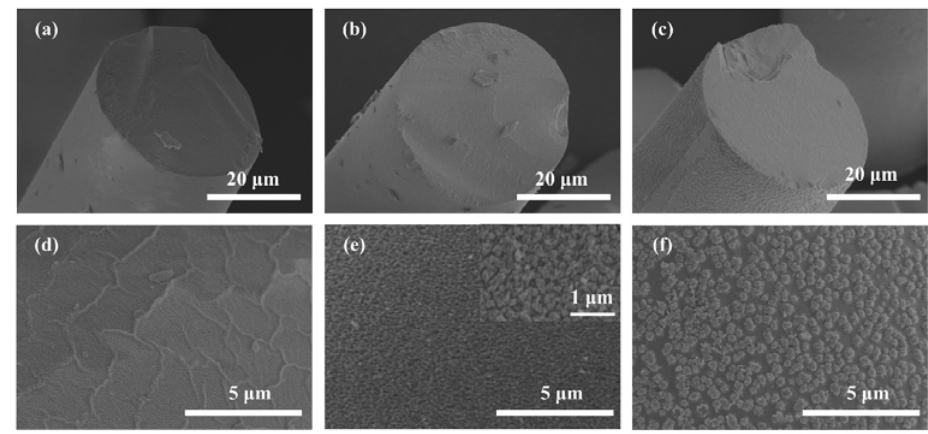
Fig. 6 SEM images of (a, d) PAWVT-135–700, (b, e) PAWVT-145–700, and (c, f) PAWVT-155–700. Preparation methods and characteristic parameter comparison of Lu 2 O 3 continuous fibers and